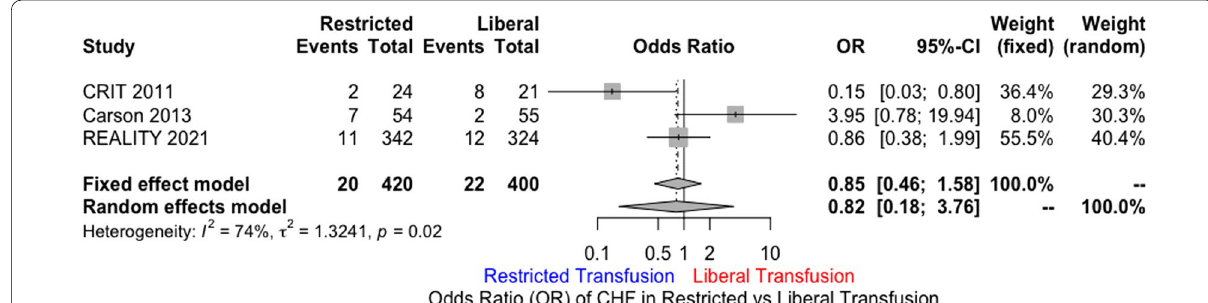
Fig. 3 Odds ratio of new or worsening congestive heart failure at 30 days. Values present are OR with 95% confidence interval, n , or percentage %. Restricted 8 g/dl; Liberal 10 g/dl ≤ ≤